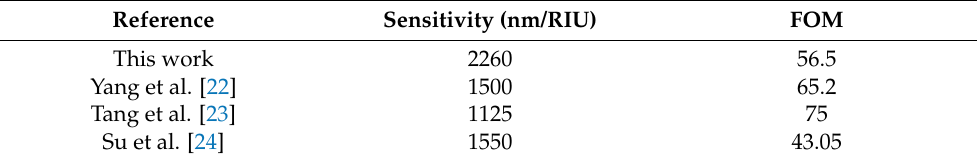
Table 1. Performance comparison of various plasmonic